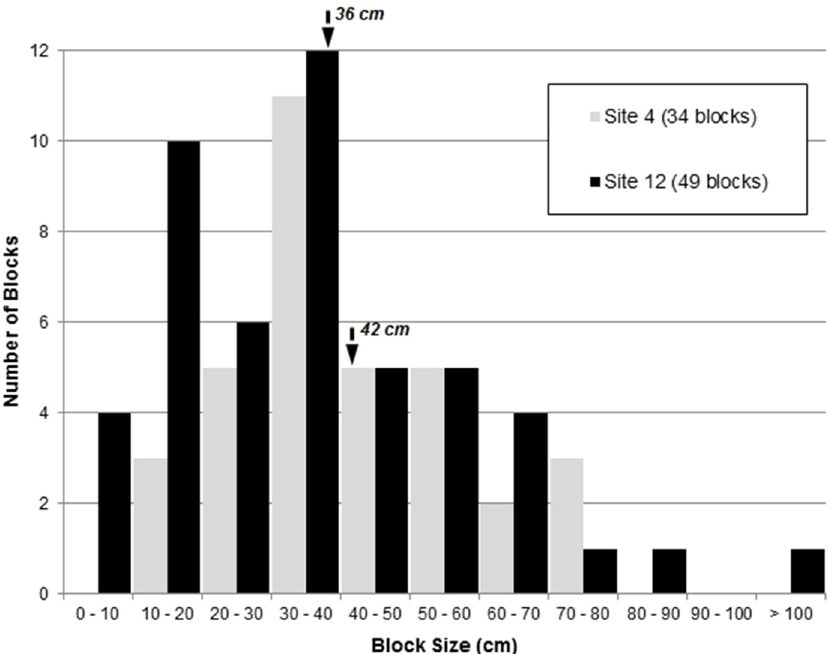
Figure 9. Block size distributions for the non-mantled Site 4 and Site 12. The average block size for each is denoted with the arrows.